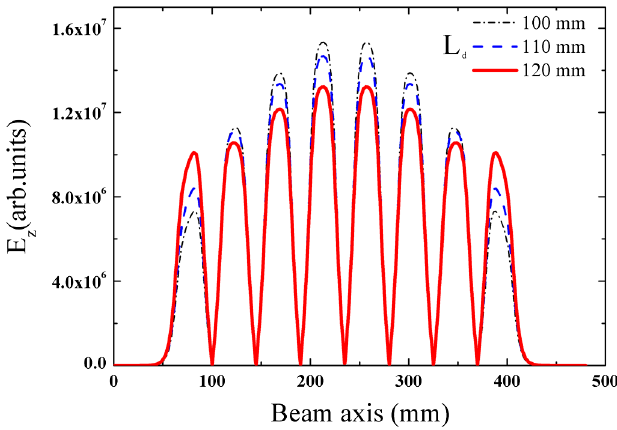
FIG. 16. A cross sectional view section of the CH test model.